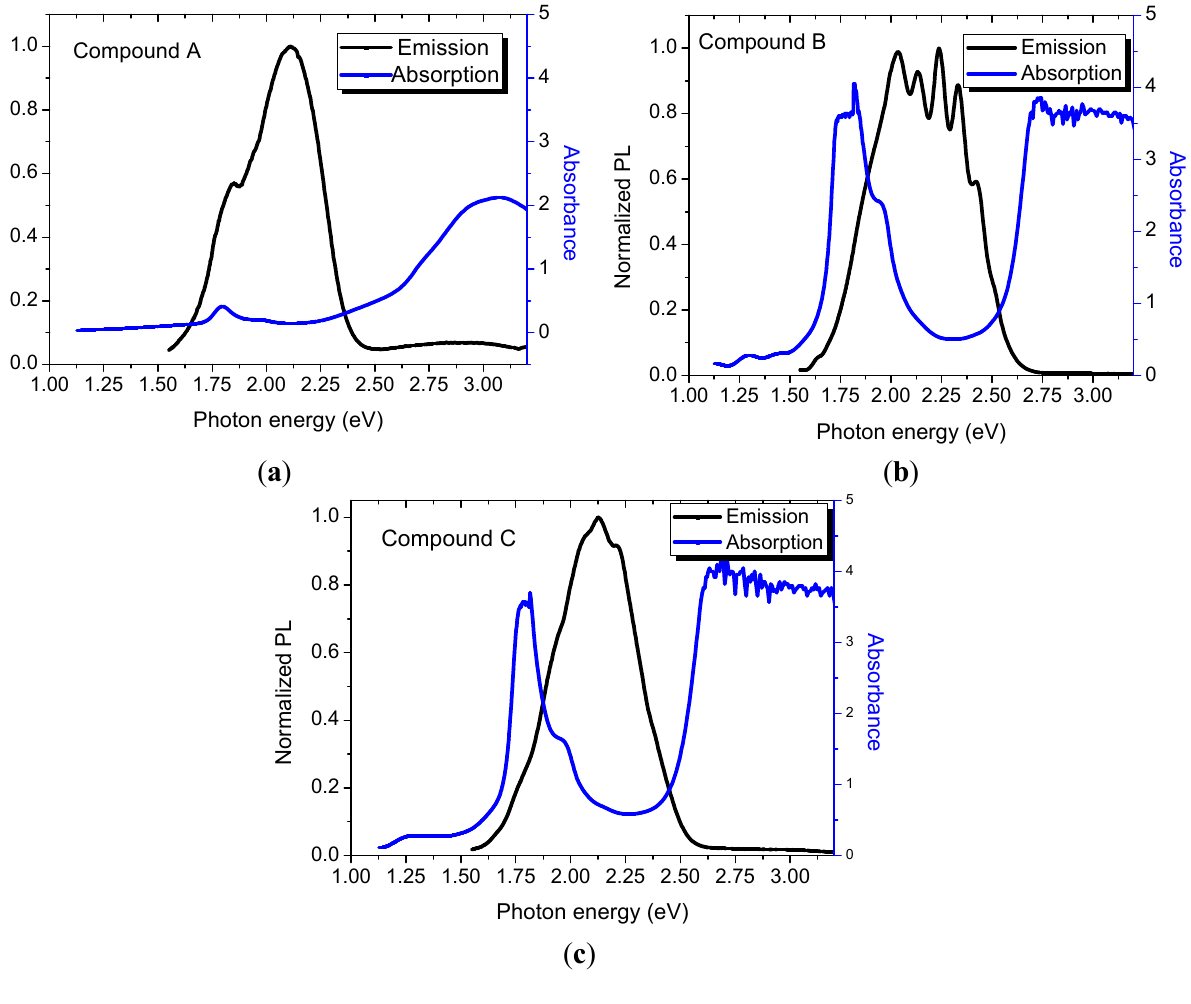
Figure 7. Normalized PL and absorbance vs. photon energy of thin films: ( a ) Film A ; ( b ) Film B ; and ( c ) Film C